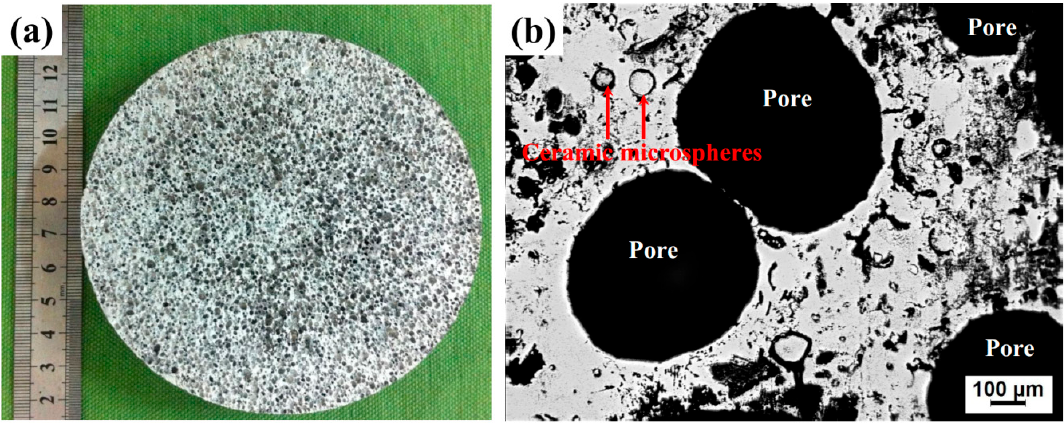
Figure 1. Cross section ( a ) and ceramic microspheres (CMs) morphology ( b ) in composite foams.